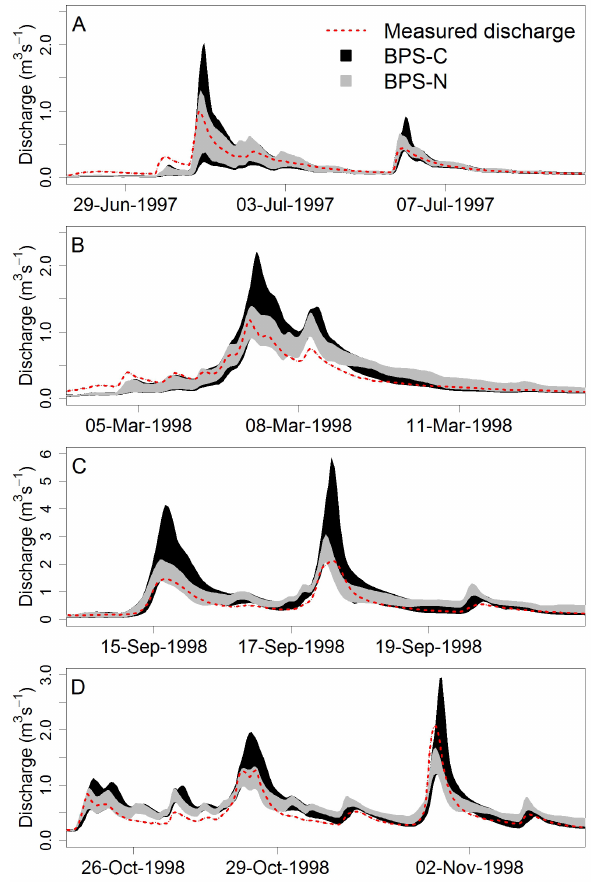
Fig. 11. Model validation results for extreme discharge events at the catchment outlet. The light grey band gives the results of the model calibrated on all nested-scale measurements, while the black band give the results of the model calibrated on catchment discharge